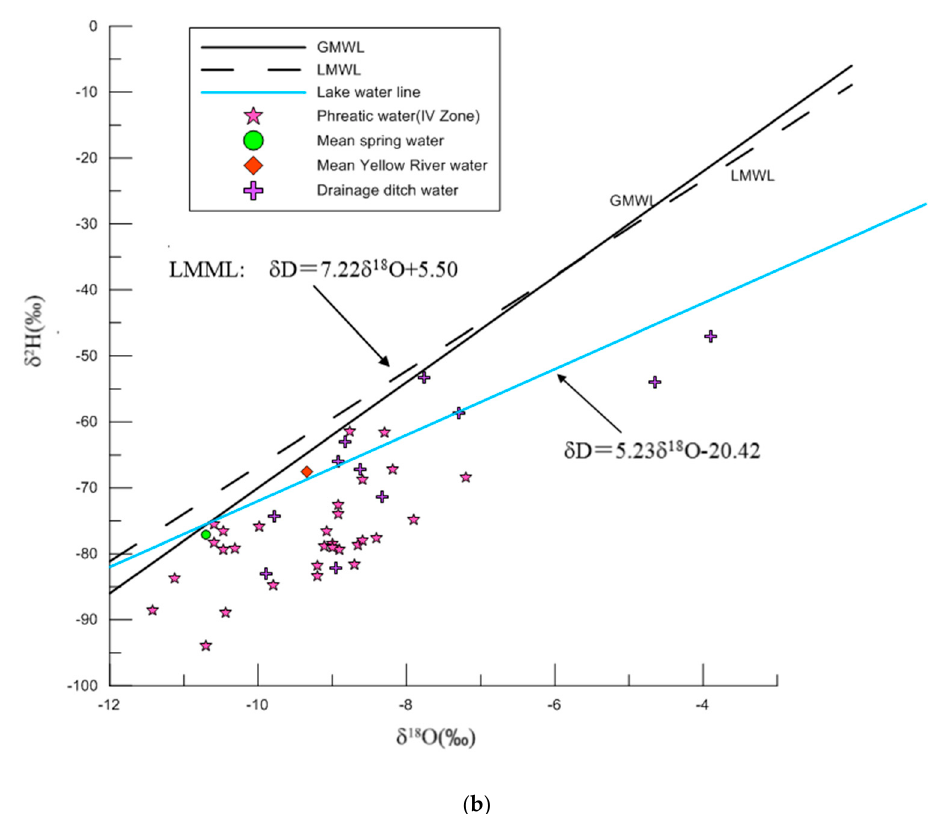
Figure 8. δ 2 H versus δ 18 O diagram of precipitation, surface water and groundwater of the Yinchuan Plain study area. ( a ) phreatic water (I,II,III Zone) and lake water. ( b ) phreatic water (IV Zone) and drainage ditch water.